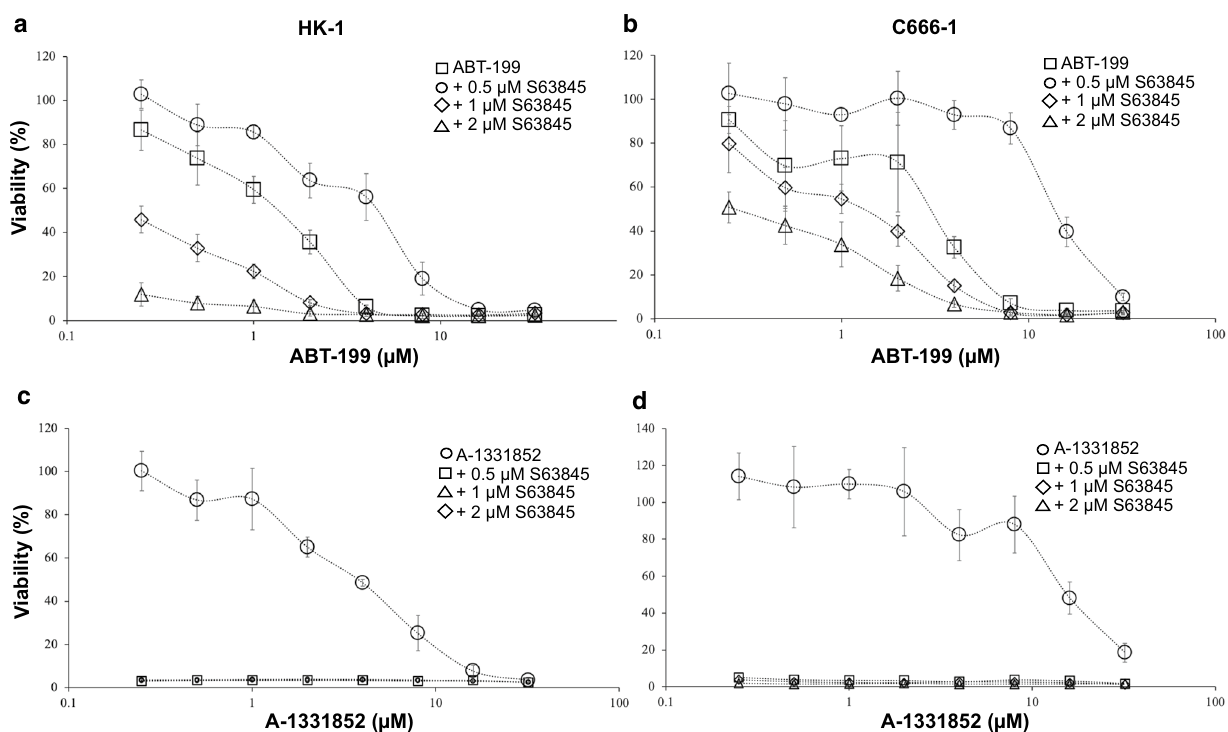
Fig. 2 Co-inhibition of BCL-2 and MCL-1 using ABT-199 and S63845. a HK-1 cells were treated with increasing concentrations of ABT-199 (0–32 μM) in the presence and absence of S63845. Points represent the SD of four experiments. b C666-1 cells were treated with increasing concentrations of ABT-199 (0–32 μM) in the presence and absence of S63845. Points represent the SD of four experiments. Co-inhibition of BCL-XL and MCL-1 using A-1331852 and S63845. c HK-1 and d C666-1 cells were treated with increasing concentrations of A-1331852 (0–32 μM) in the presence and absence of S63845. Points represent the SD of four